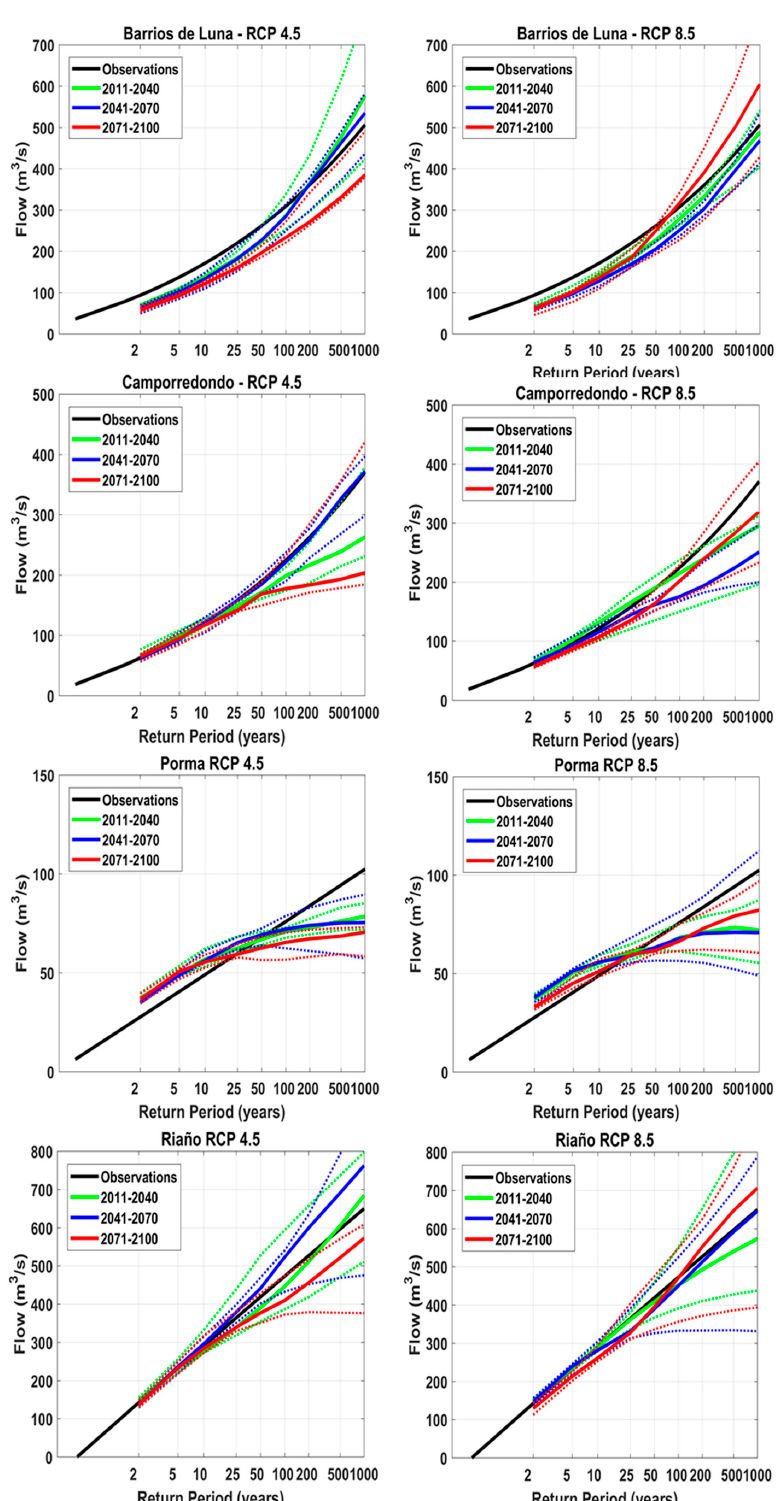
Figure 12. Expected flood frequency curves in the future periods (2011–2040, 2041–2070 and 2071–2100) with the best bias correction techniques identified in the previous section. The dotted lines show the Q 33 and Q 67 percentiles for each period. The first column shows the results for RCP 4.5 and the second column for RCP 8.5. The first raw shows results for the Barrios de Luna catchment, the second for Camporredondo, the third for Porma and the fourth for